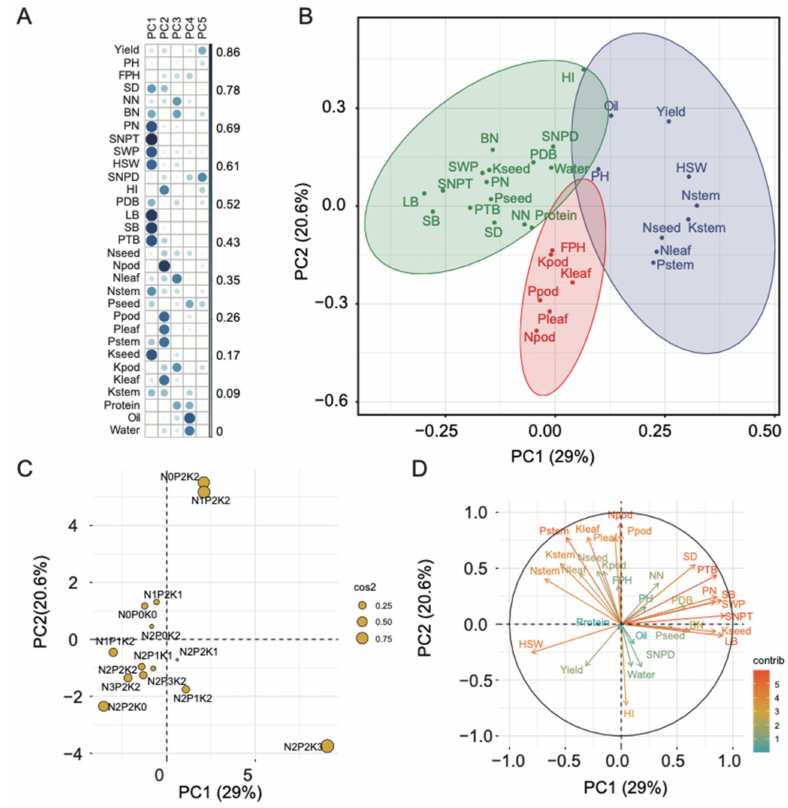
Figure 2. The principal component analysis of 31 traits. ( A ) The heatmap of 31 traits on the first five principal components, the depth of color indicates the level of trait contribution on the corresponding PC, ( B ) PCA plot for 31 traits, ellipses and shapes show clustering of traits, ( C ) principal component analysis for 14 treatments, circle size means the square cosine, ( D ) the contribution for 31 traits on PC1 and PC2, the length indicates the quality of trait. Yield, Grain yield; PH, Plant height; FPH, First pod height; SD, Stem diameter; NN, Number of nodes on main stem; BN, Branch number; PN, Pod number; SNPT, Seed number per plant; SWP, Seed weight per plant; HSW, 100-seed weight; SNPD, Seed number per pod; HI, Harvest index; PDB, Biomass per pod; LB, Biomass per leaf; SB, Biomass per stem; PTB, Biomass per plant; Nseed, N content in seed; Npod, N content in pod; Nleaf, N content in leaf; Nstem, N content in stem; Pseed, P content in seed; Ppod, P content in pod; Pleaf, P content in leaf; Pstem, P content in stem; Kseed, K content in seed; Kpod, K content in pod; Kleaf, K content in leaf; Kstem, K content in stem; Protein, Protein content; Oil, Oil content; Water, Water content. The correlation analysis showed that biomass per plant was significantly and positively associated with yield component traits such as stem diameter ( r = 0.87, p < 0.001), pod number ( r = 0.86, p < 0.001), seed number per plant ( r = 0.86, p < 0.001), and seed weight per plant ( r = 0.86, p < 0.001), while significantly and negatively associated with hundred seed weight (HSW, r = − 0.72, p < 0.01). There was a negative correlation between protein and oil contents ( r = − 0.78, p < 0.001). The K in the seeds was positively correlated with pod number ( r = 0.84, p < 0.001), seed number per plant ( r = 0.91, p < 0.001), seed weight per plant ( r = 0.83, p < 0.01), and biomass per pod ( r = 0.45, p < 0.01). Furthermore, the K in the seeds was positively associated with K in the leaf ( r = 0.73, p < 0.01), stem ( r = 0.67, p < 0.01), and plant ( r = 0.74, p < 0.01). The N in the pod was significantly and